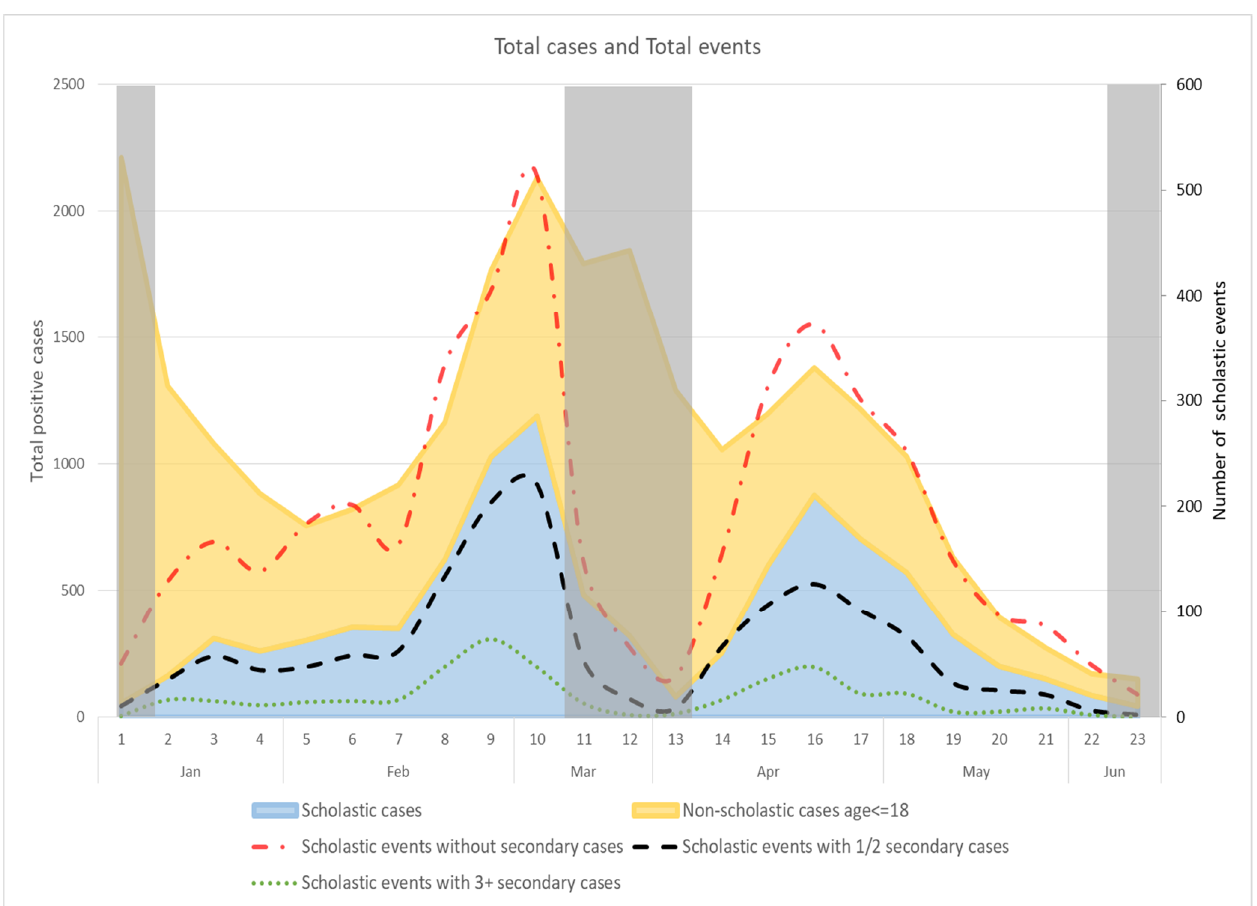
Figure 5. Total cases found positive in the school population (overall and school-related). Gray areas represent periods when schools were closed. Table 2. Distribution of school-related secondary cases by type of